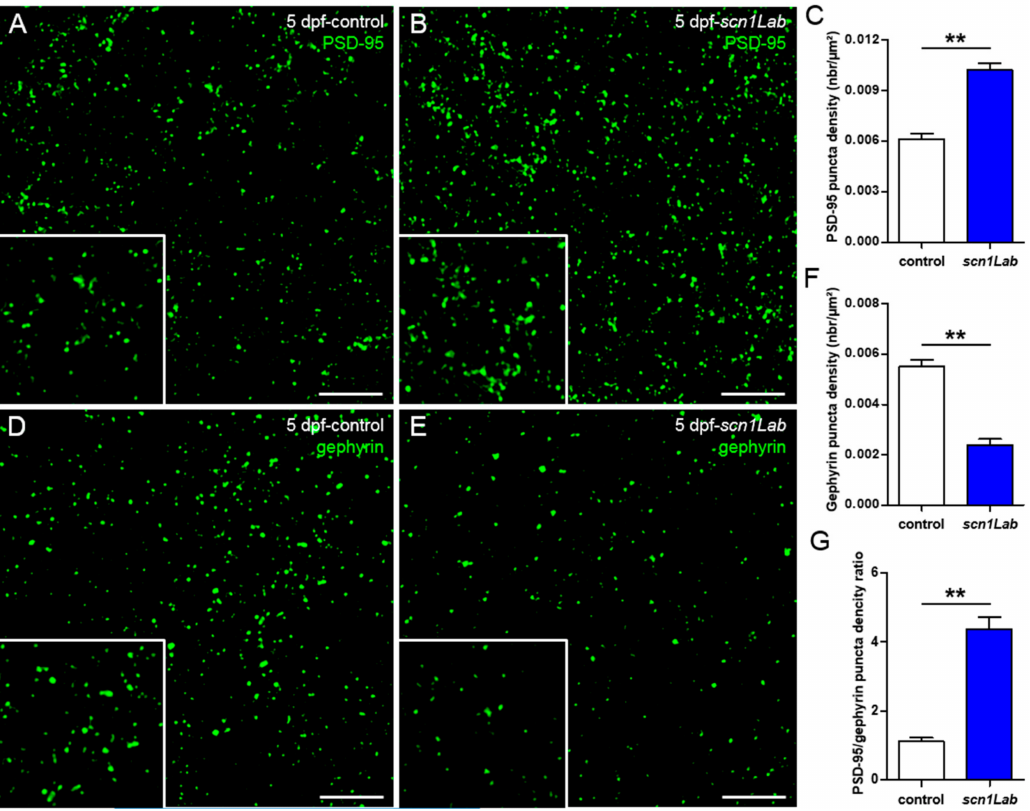
Figure 2. Defects of excitatory / inhibitory balance in the Scn1Lab-depleted larvae. ( A , B ) 20 µ m coronal sections of 5 dpf control ( A ) ( N = 5, n = 15) and scn1Lab ( B ) ( N = 5, n = 15) larvae stained with PSD-95, an excitatory post-synaptic sca ff olding protein. ( D , E ) 20 µ m coronal sections of 5 dpf control ( D ) ( N = 5, n = 20) and scn1Lab ( E ) ( N = 5, n = 19) larvae stained with gephyrin, an inhibitory post-synaptic sca ff olding protein. Images were acquired with a SP8 Leica laser scanning confocal microscope equipped with a 40x / oil 1.3 objective. Scale bar 5 µ m. ( C , F ) Quantification of PSD-95 ( C ) and gephyrin ( F ) puncta density. ( G ) PSD-95 / gephyrin puncta density ratio. N = number of larvae and n = number of sections. Error bars on all graphs represent standard error mean (SEM). **, p < 0.01. p -values